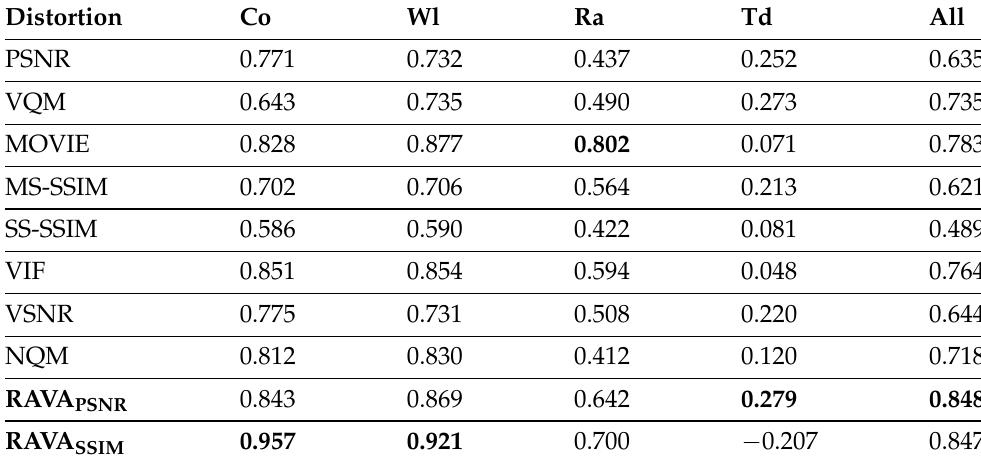
Table 5. Comparison of PCC (Pearson correlation coefficient)—tablet.